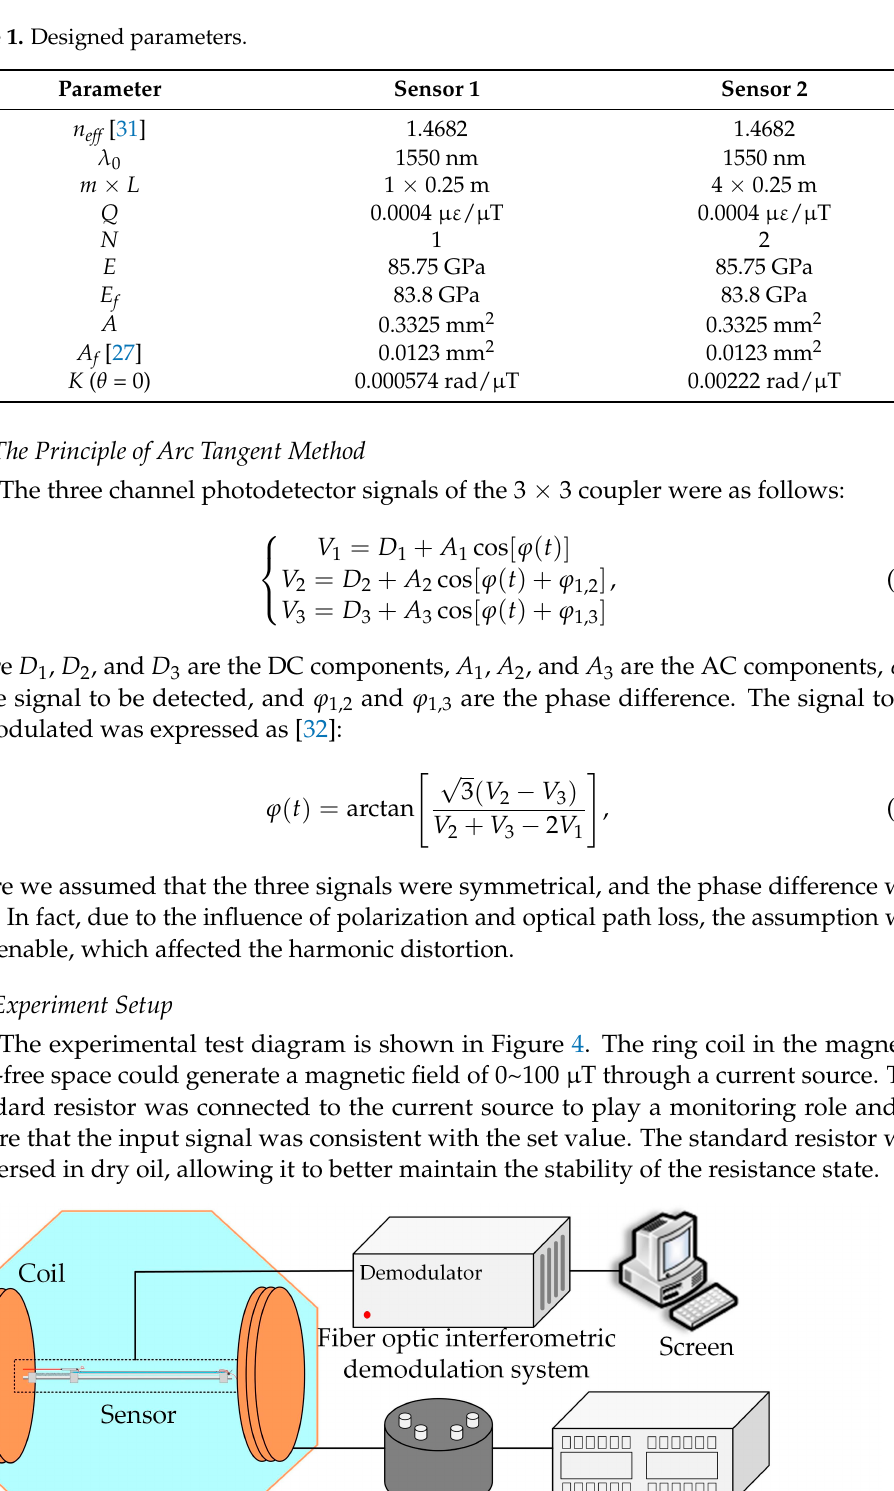
Figure 5. The uniform magnetic field is generated by applying current to the coil in zero magnetic space. As shown in Figure 6, two optical fiber magnetic field sensors were placed in the uniform area of the central magnetic field of the ring coil, and the linearity, frequency response, and directivity of the two sensors were tested. The signals were demodulated and stored using an optical fiber interferometric phase demodulation system.